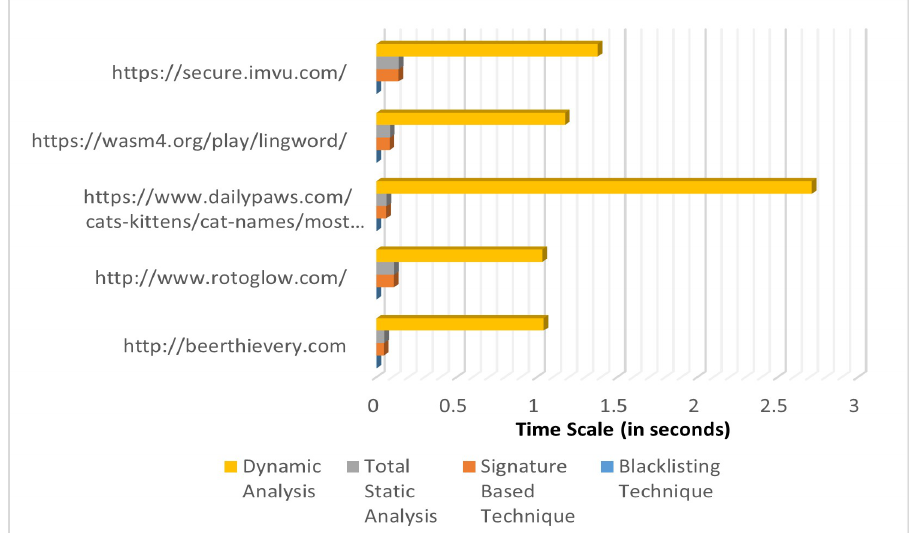
Figure 4. Performance Comparison between Static and Dynamic Approaches.